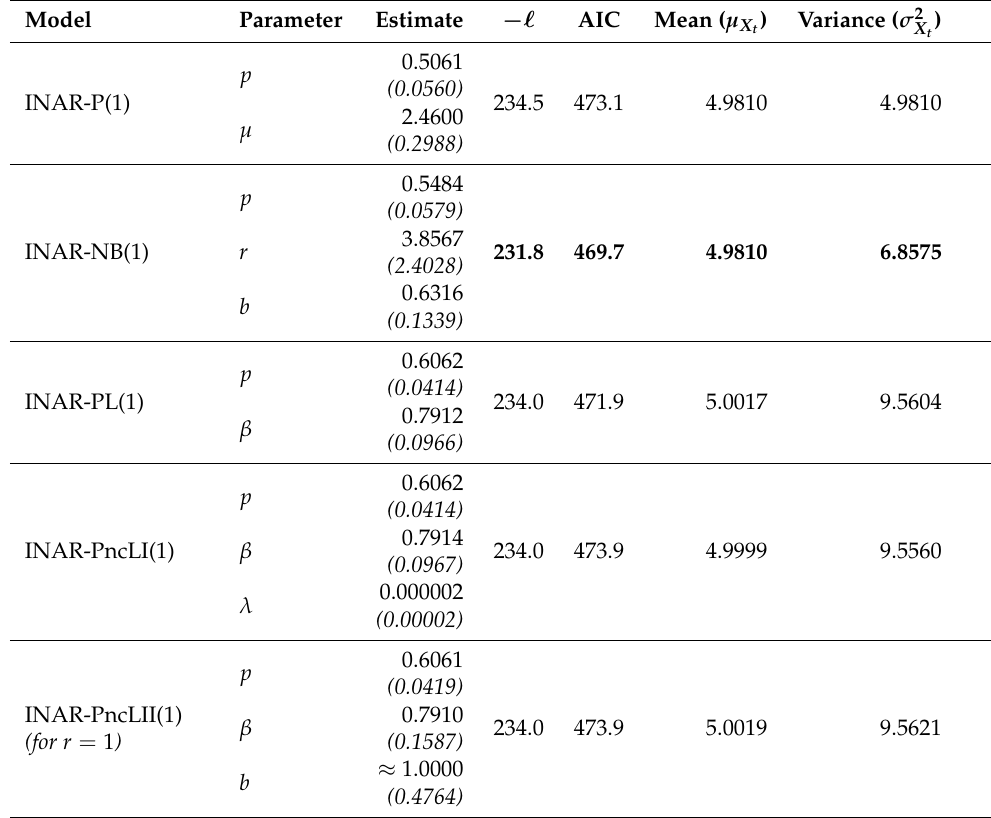
Table 3. Estimated parameters (with standard errors in parentheses), goodness of fit statistics, fitted mean, and fitted variance of considered models for the strike